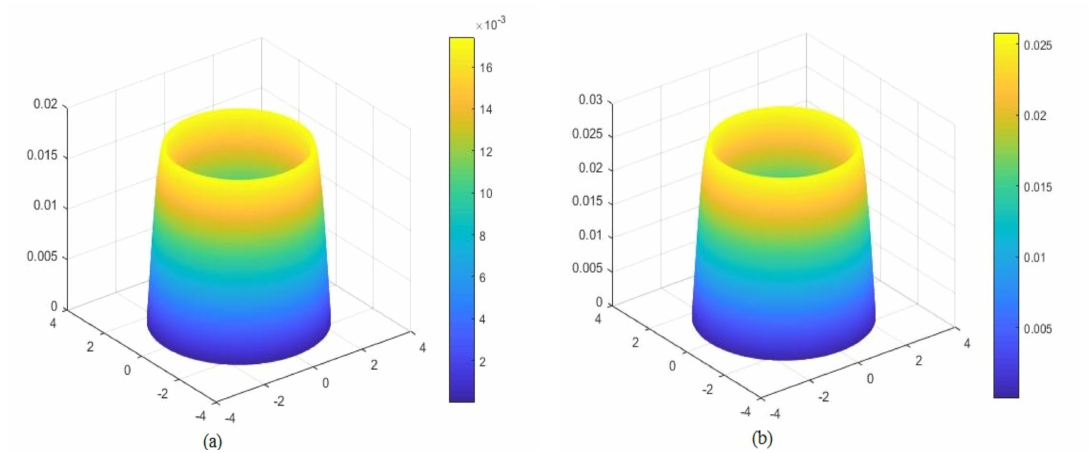
Figure 6. ( a ) The NBE solution u k at t = 1. ( b ) The analytical solution u k